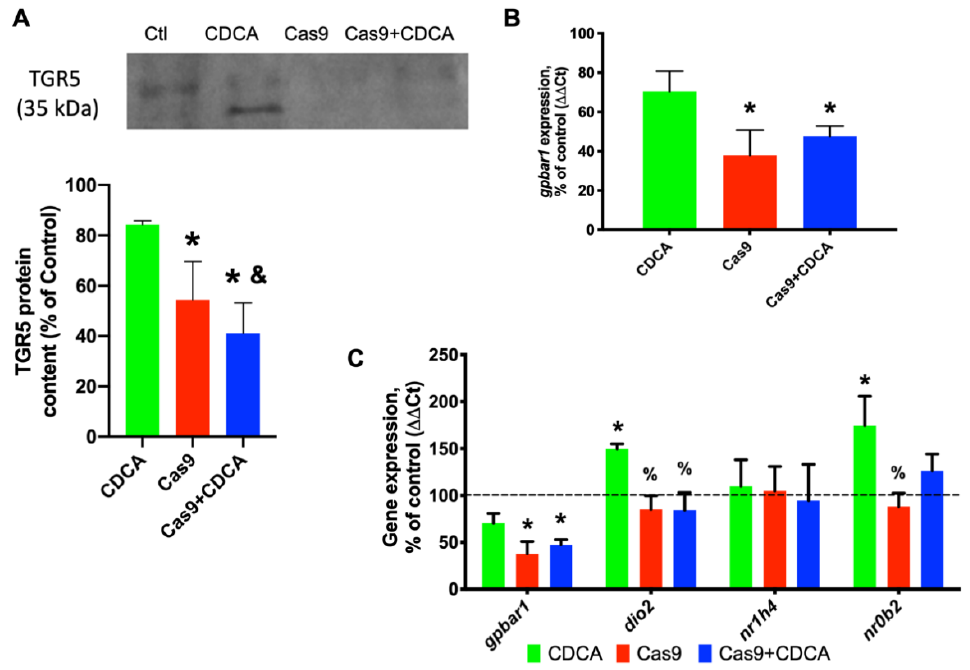
Figure 1. Confirmation of the experimental model. ( A ) Western Blot representative image for TGR5 and quantification of protein content; ( B ) Gene expression (as percentage of control) for gpbar1 , TGR5 ′ s gene; and ( C ) Gene expression (as percentage of control) for the TGR5 downstream effector deiodinase 2 (D2, dio2 ), and the other BA receptor FXR ( nr1h4 ) and its downstream gene, the small heterodimer protein (SHP, nr0b2 ). Data are derived from six independent experiments, and bars represent means ± SEM. * indicates a statistically significant difference vs. Control ( p < 0.05); % indicates a statistically significant difference vs. CDCA ( p < 0.05); & indicates a statistically significant difference vs. Cas9 ( p < 0.05).